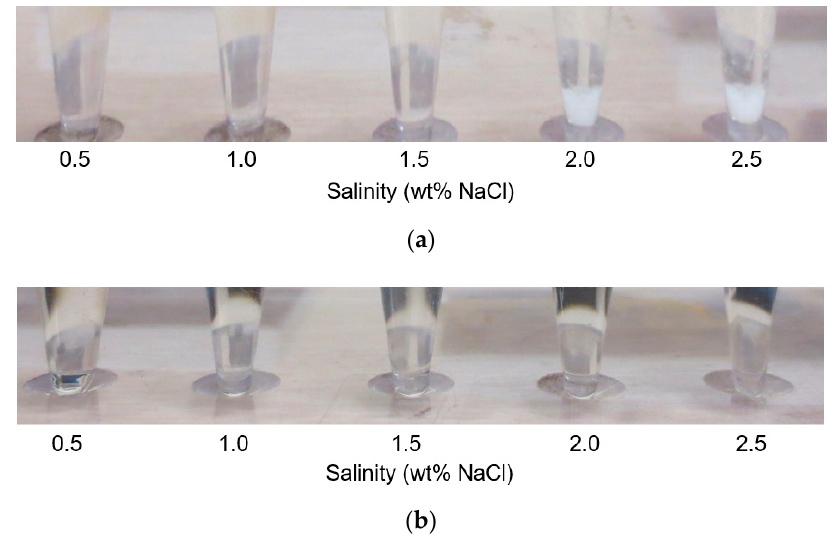
Figure 3. Results of the aqueous stability test of ( a ) 0.2 wt% heavy alcohol (IBA; the reference case); ( b ) 0.2 wt% nonionic surfactant (LB-95; the proposed case) mixing with 0.25 wt% 1:4 (wt / wt) of LAS and DOSS anionic surfactant pair, 0.2 wt% Na 2 CO 3 as the alkali, and 0.15 wt% HPAM as the polymer.